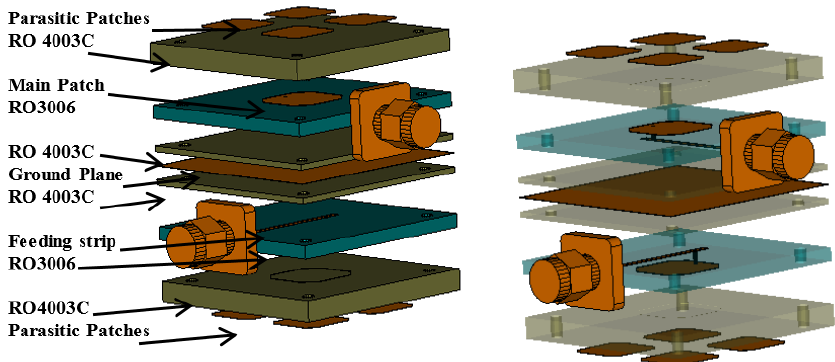
Figure 3. The wideband MIMO antenna stacked structure. Table 1. Wideband MIMO antenna optimal design variables (all sizes in mm).